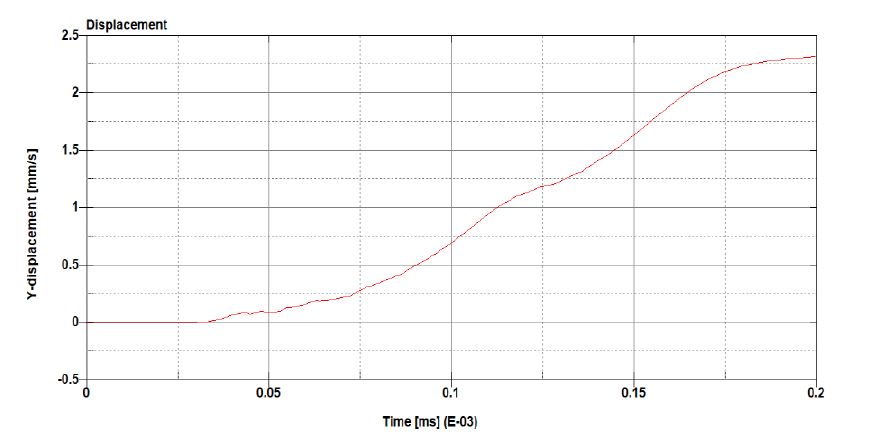
Figure 30 – Displacement of the armor plate in relation to time Рис. 30 – Смещение в зависимости от времени Слика 30 – Померање у зависности од